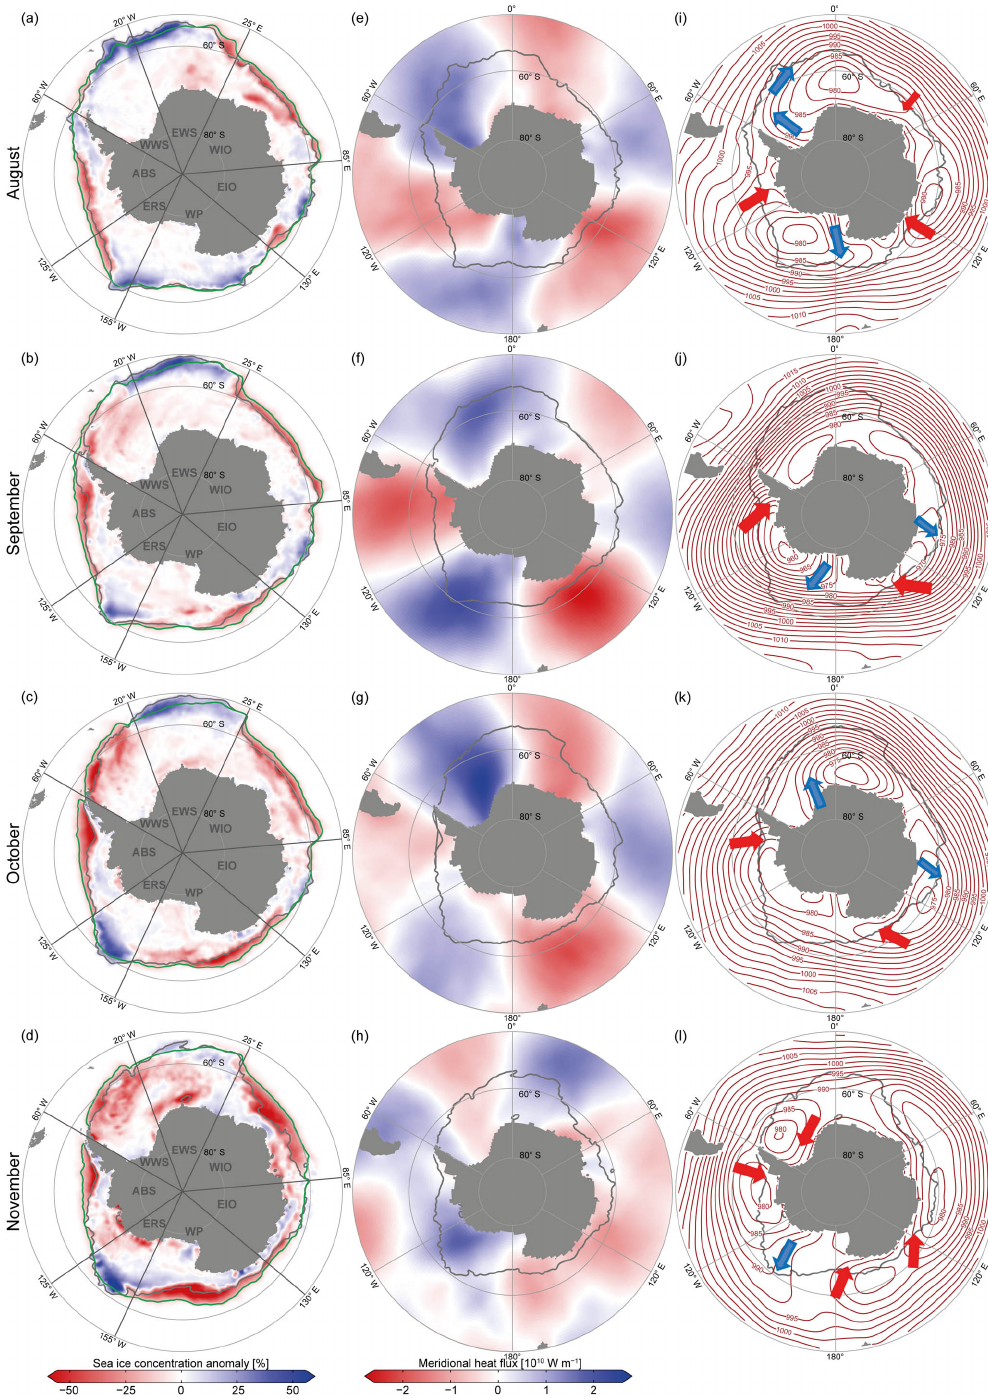
Figure 3. (a–d) Monthly mean SIC anomalies for the months August to November 2016 derived from the NRT data (red; Maslanik and Stroeve, 1999, updated daily; provided by NSIDC). Anomalies are calculated with respect to the climatological monthly mean derived from the CDR NT data from the period 1979 through 2015 (Meier et al., 2013; provided by NSIDC). Regions for the regional analysis (Fig. 5) are indicated by the black lines and defined in Table 1. The gray and green contour lines denote the 2016 and the climatological (1979–2015) mean sea ice edge (15% SIC), respectively. (e–h) Monthly mean vertically integrated meridional heat fluxes (positive northward) from ERA- Interim (Dee et al., 2011) for the months August to November 2016. (i–l) Monthly mean sea level pressure from ERA-Interim for the months August to November 2016. Arrows indicate the approximate atmospheric flow